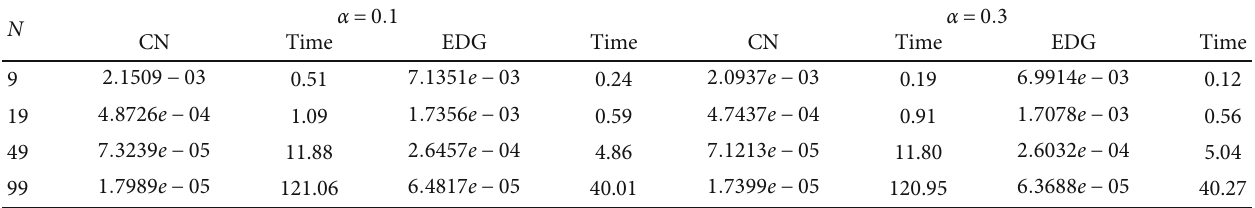
Table 5: Absolute errors of Example 15 at T = 1 for Re = 5 , Δ t = 0 : 01 , α = 0 : 1 , and α = 0 : 3 .